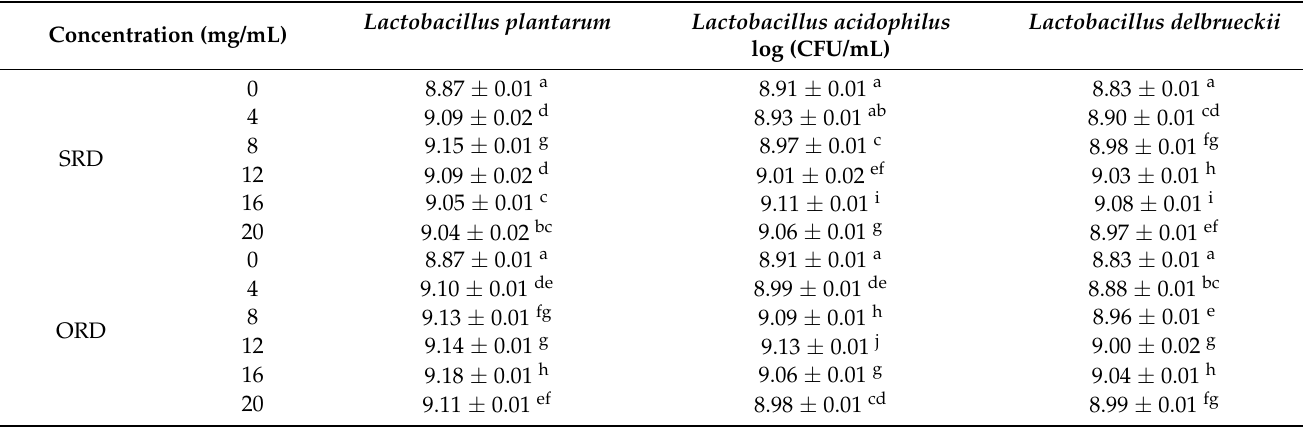
Table 3. Effects of resistant dextrin digesta on the proliferation of Lactobacillus plantarum, Lacto- bacillus acidophilus and Lactobacillus delbrueckii ((X ± S) log CFU/mL). Lactobacillus plantarum Concentration (mg/mL)